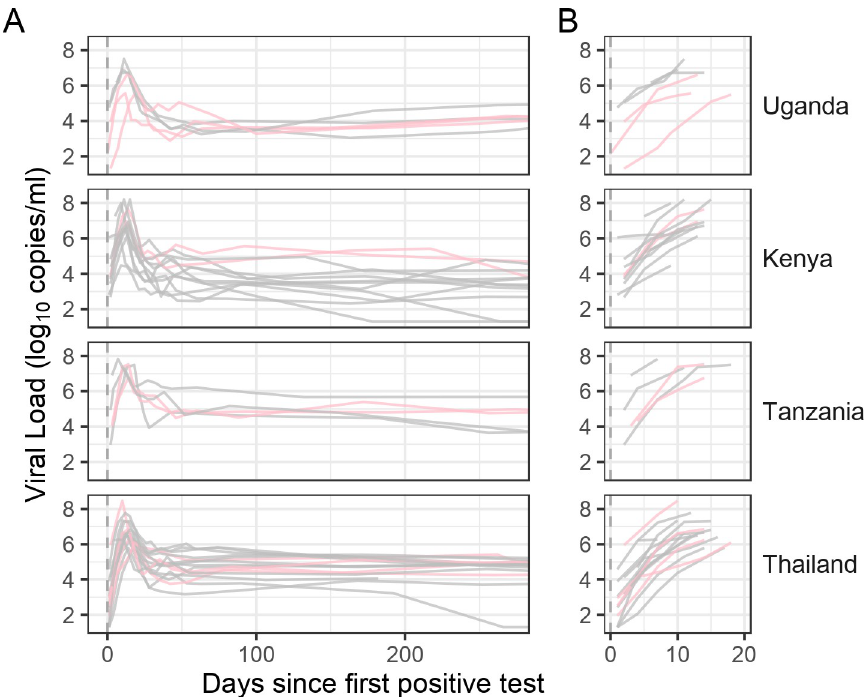
Fig 1. Longitudinal viral loads for 39 RV217 participants. Day 0 corresponds to the first HIV-1 positive RNA test, also referred to as diagnosis. The last negative HIV-1 RNA test occurred a median of 4 days prior to diagnosis for these participants. Panel B zooms in on the viral loads from diagnosis to peak. Participants with single founders are represented in grey, those with multiple founders in pink.